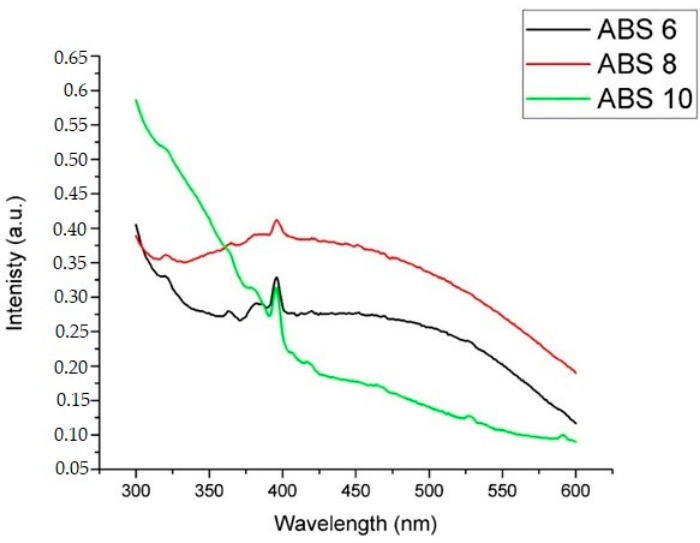
Figure 18. The absorption spectra of YAG:Eu (black—6%; red—8%; green—10%).